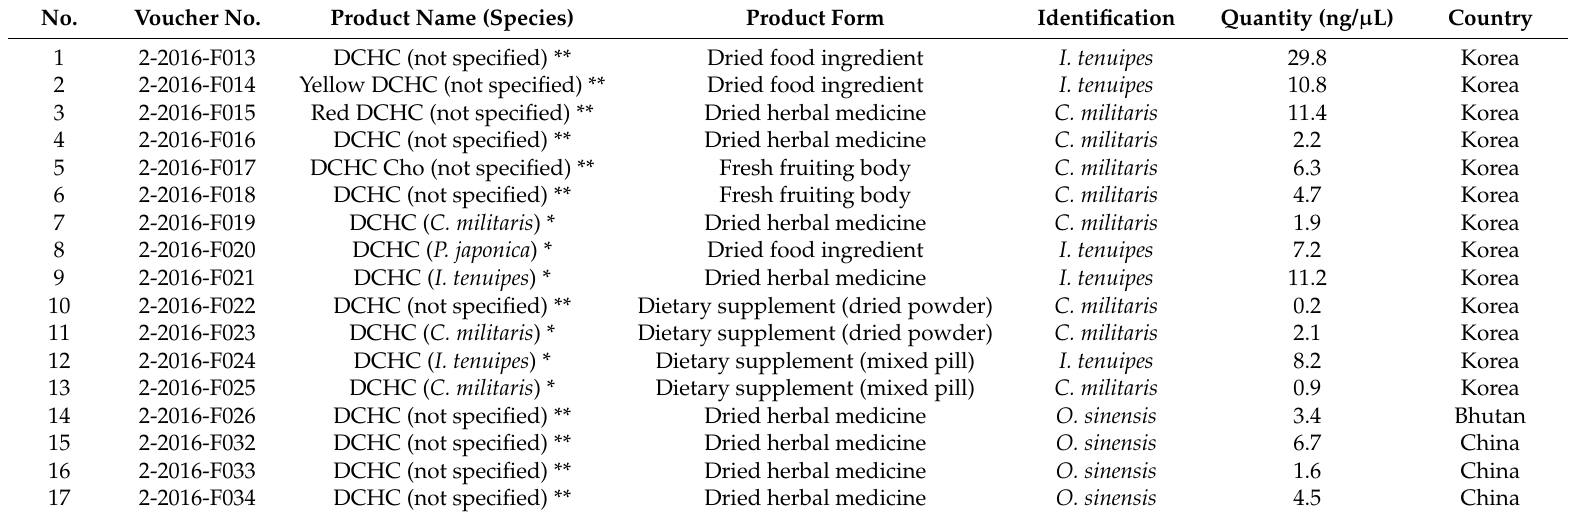
Table 5. The sensitivities, efficiencies, and correlation coefficients of the real-time PCR